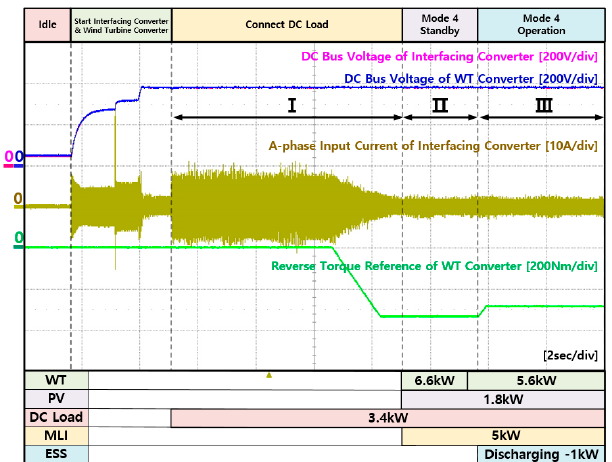
Figure 22. Experiment waveforms of interfacing converter and WT converter in mode 4.